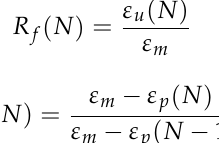
Table 2. Results of the thermocycle cantilever tests.